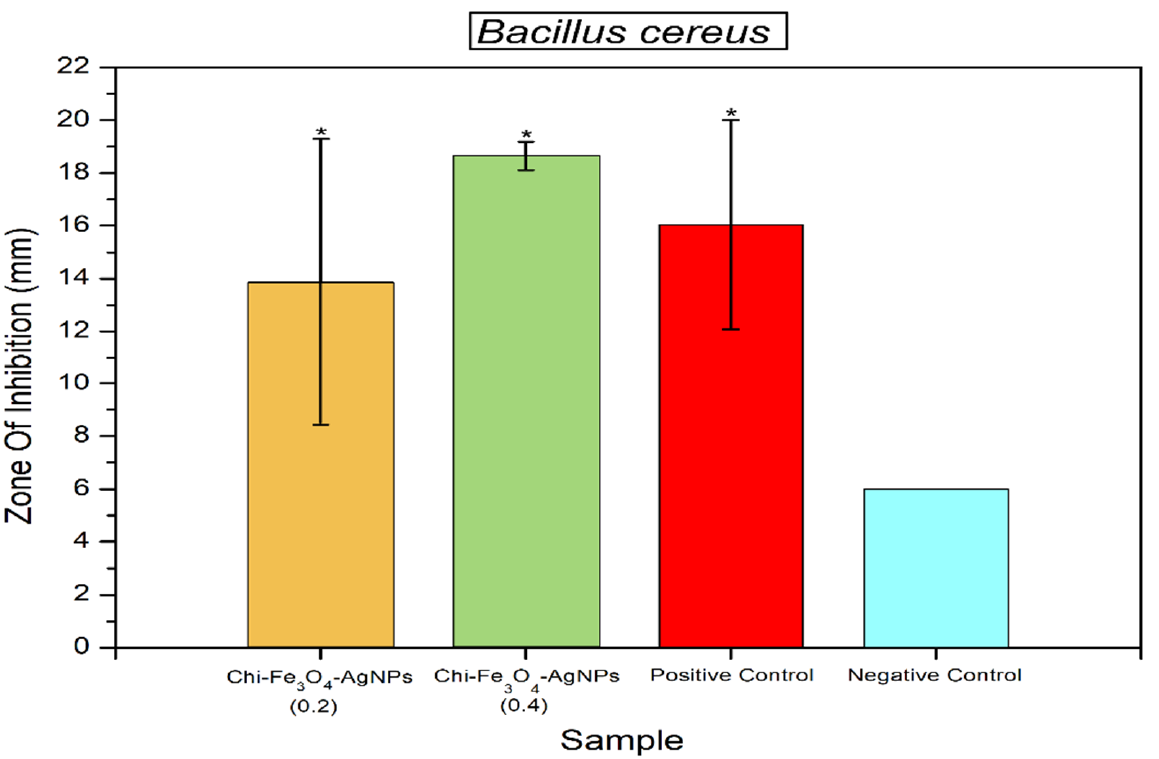
Figure 8. Antibacterial activity of Fe 3 O 4 @Chitosan-AgNPs against B. cereus . Mean ± SD ( n = 3); * p < 0.05 significant change compared with the negative control